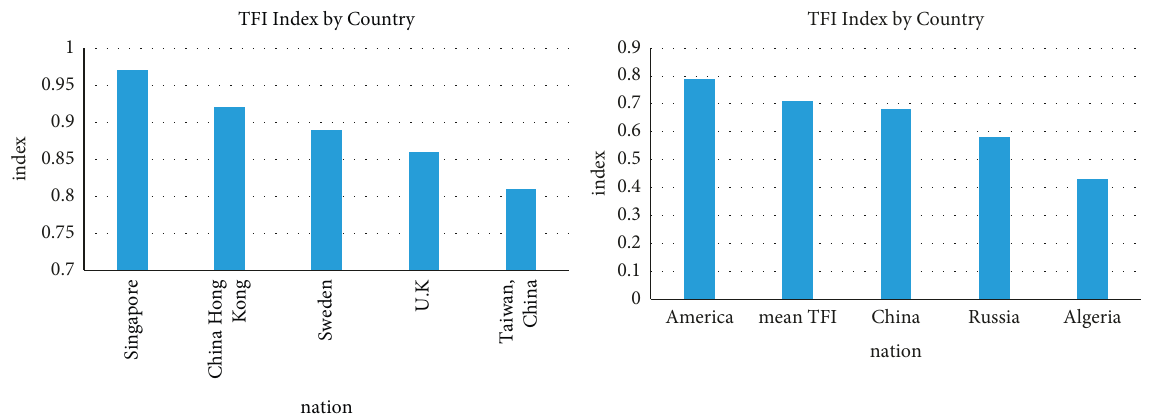
Figure 6: 2011 TFI index by